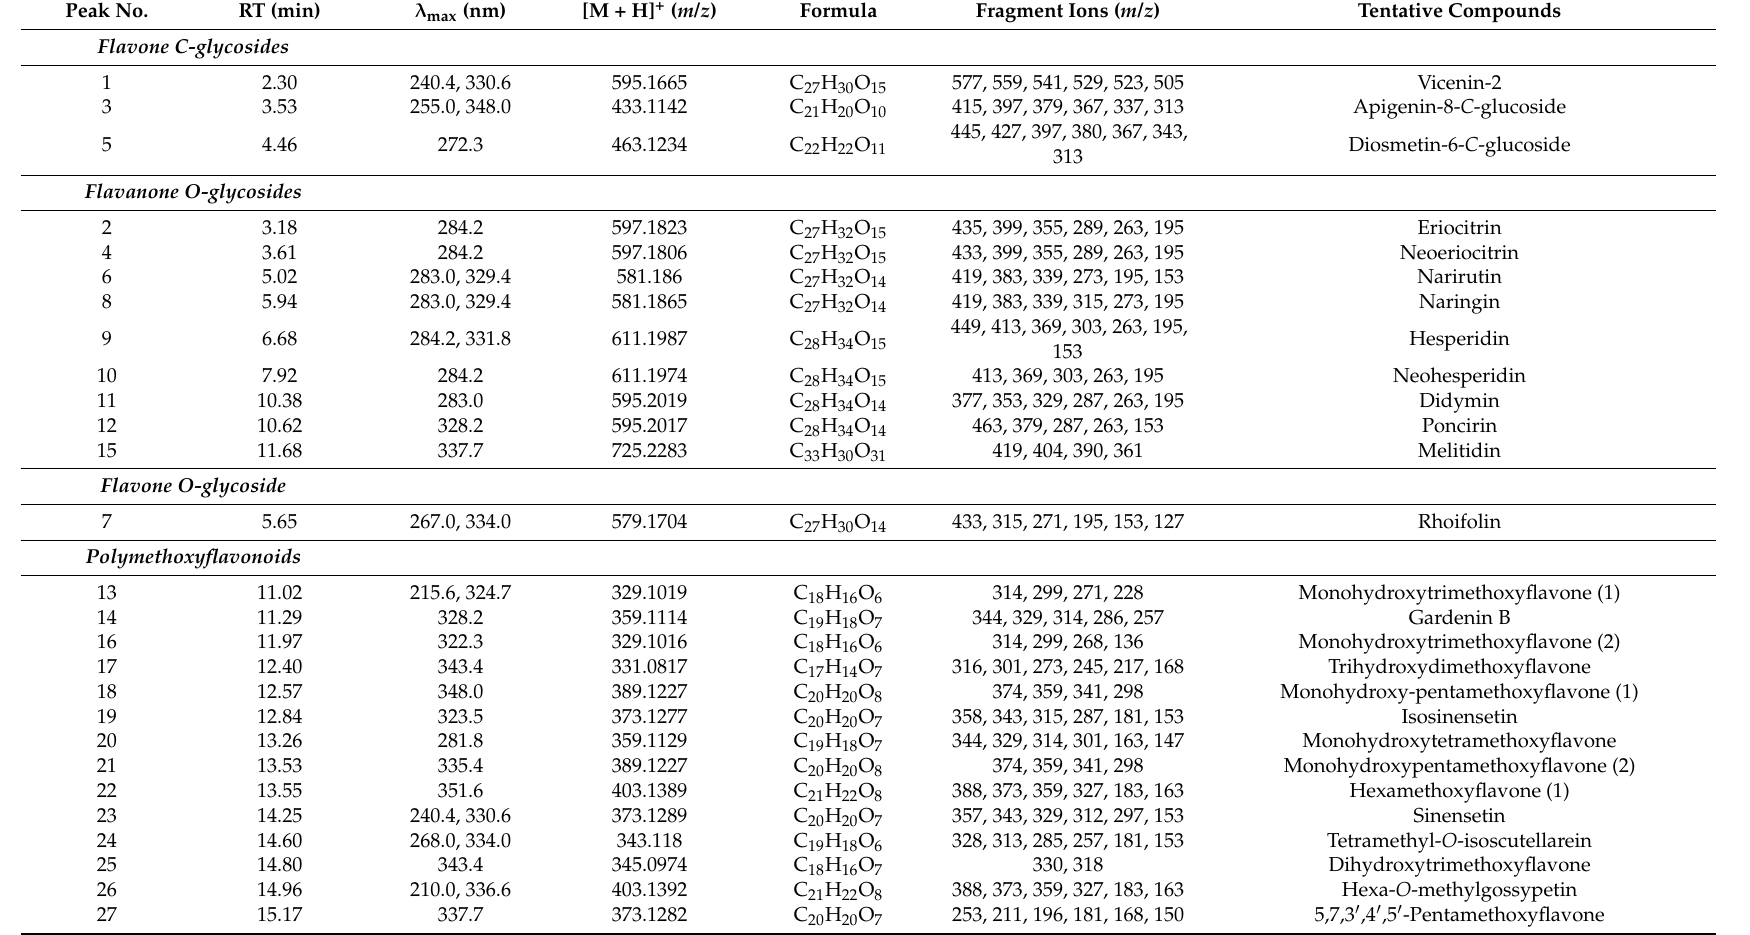
Table 7. Determination of flavonoids from citrus fruits by LC-ESI-MS/MS (+ESI mode) and UPLC-DAD. Peak